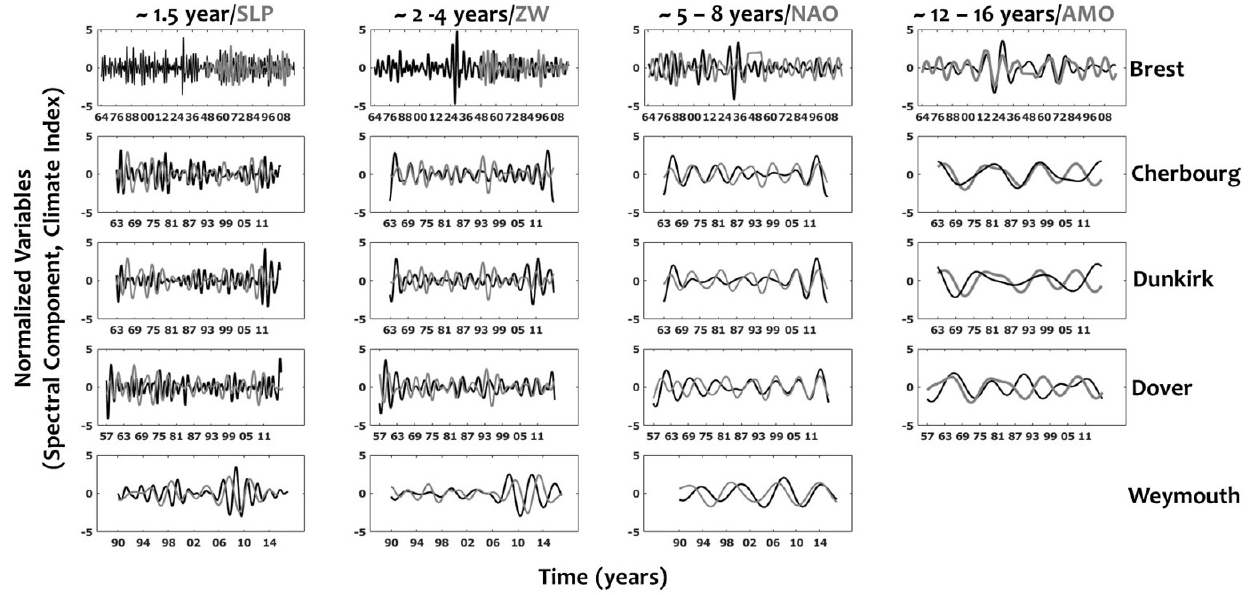
Figure 9. Wavelet details of monthly extreme surges (black lines), at the interannual ( ∼ 1.5, ∼ 2–4 and ∼ 5–8 years) and interdecadal ( ∼ 12–16 years) timescales for all sites (Brest, Cherbourg, Dunkirk, Dover and Weymouth), correlated to the spectral component of climate oscillations associated with the different indices SLP, ZW, NAO and AMO (grey line). Only the connection maximizing the correlation coefficient between a selected climate index and the component of surges (from interannual to interdecadal timescales) is presented (the normalized values have been calculated to superpose both